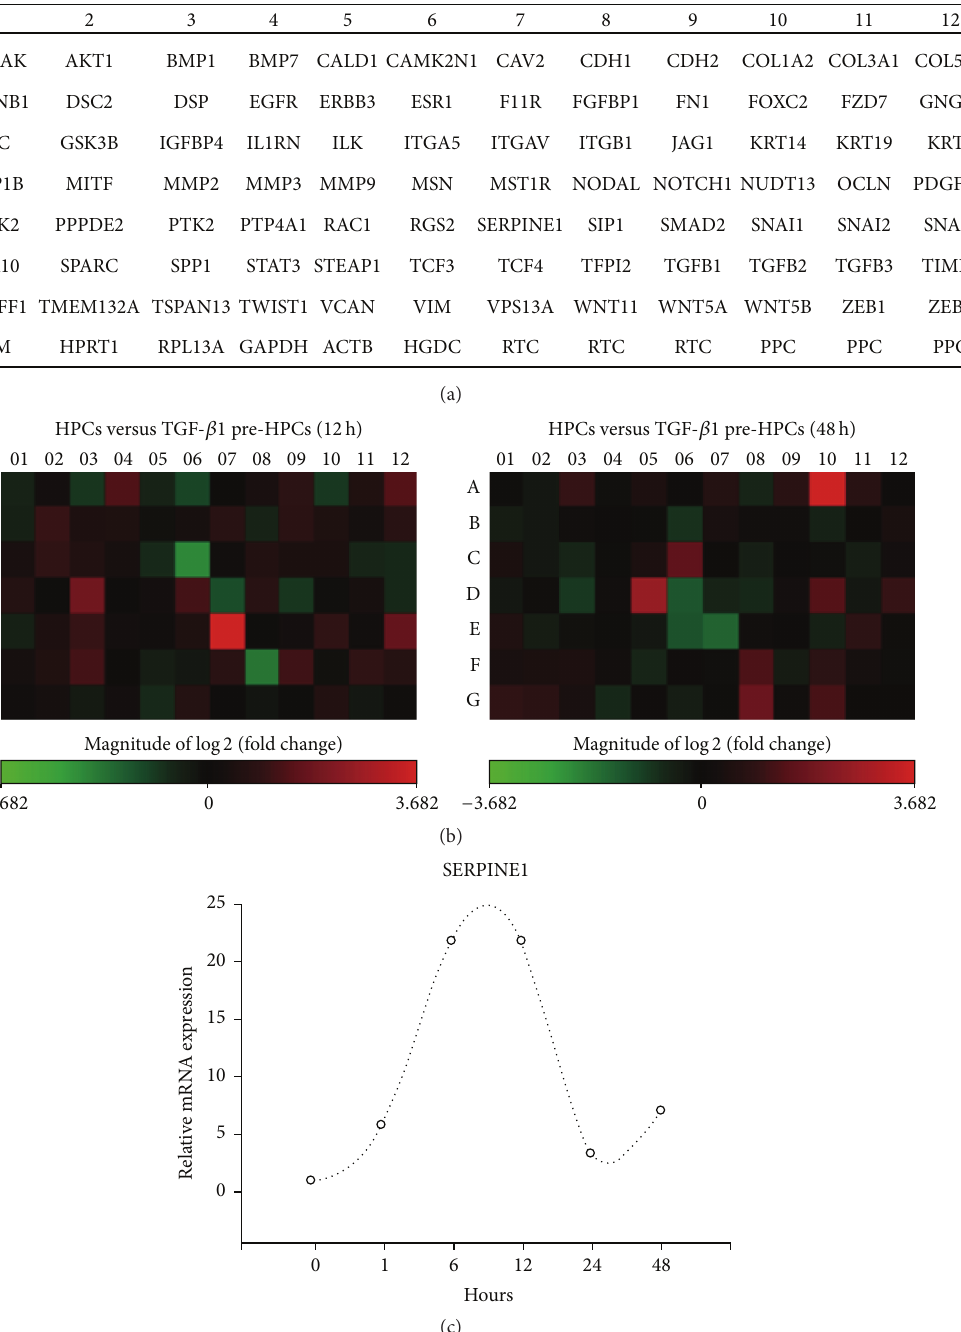
Figure 6: SERPINE1 is required for HPC-mediated amelioration of liver injury induced by an injection of CCl 4 . The layout of the genes included in the EMT Pathway Finder PCR Array (a). The heat map of the variations in the expression levels of 84 genes between control HPCs and HPCs treated with TGF- 𝛽 1 for 12 h or 48h is shown as a fold increase or decrease (b). Validation of SERPINE1 expression by real-time PCR analysis (c). All data are expressed as the mean ± SD from three independent